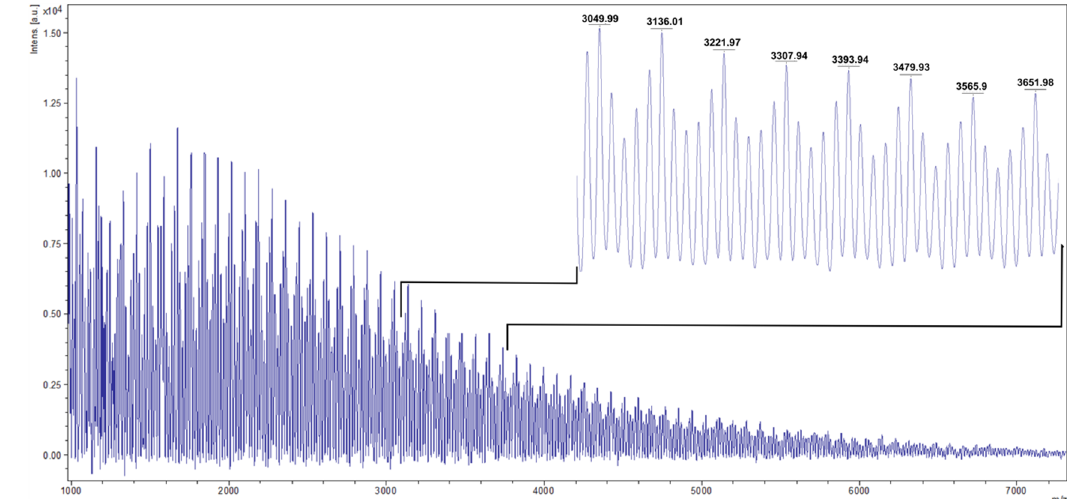
Figure 7. MALDI spectrum of isolated PHB produced by Pseudomonas sp. phDV1 grown in M9 minimal media supplemented with 600 mg/L phenol as the sole carbon source .